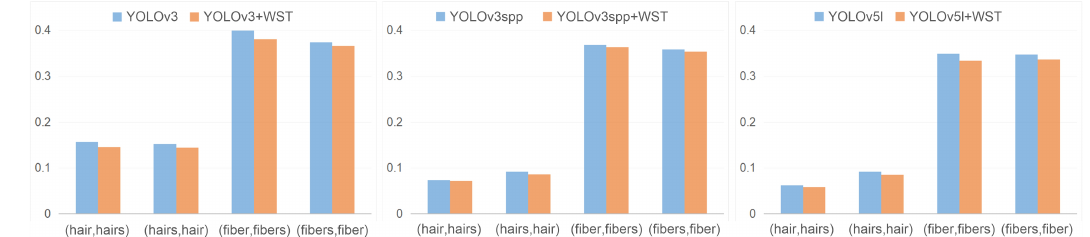
Figure 14. The hardest fractal object detection group (fiber and fibers) and the second-hardest fractal object detection group (hair and hairs) in Figure 12 are presented in the form of histograms.